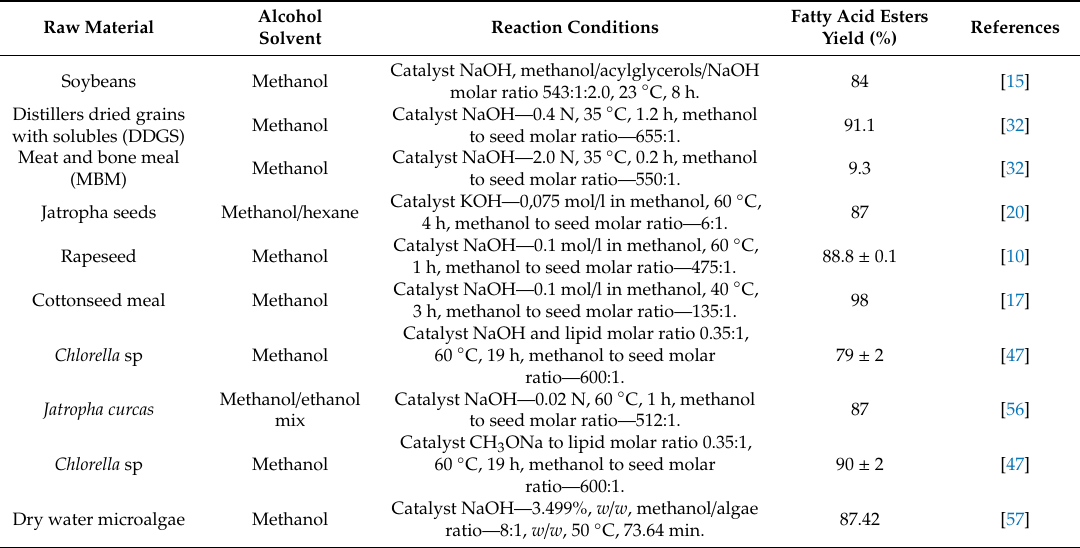
Table 2. Summary of studies on using chemical alkaline catalysts for in situ